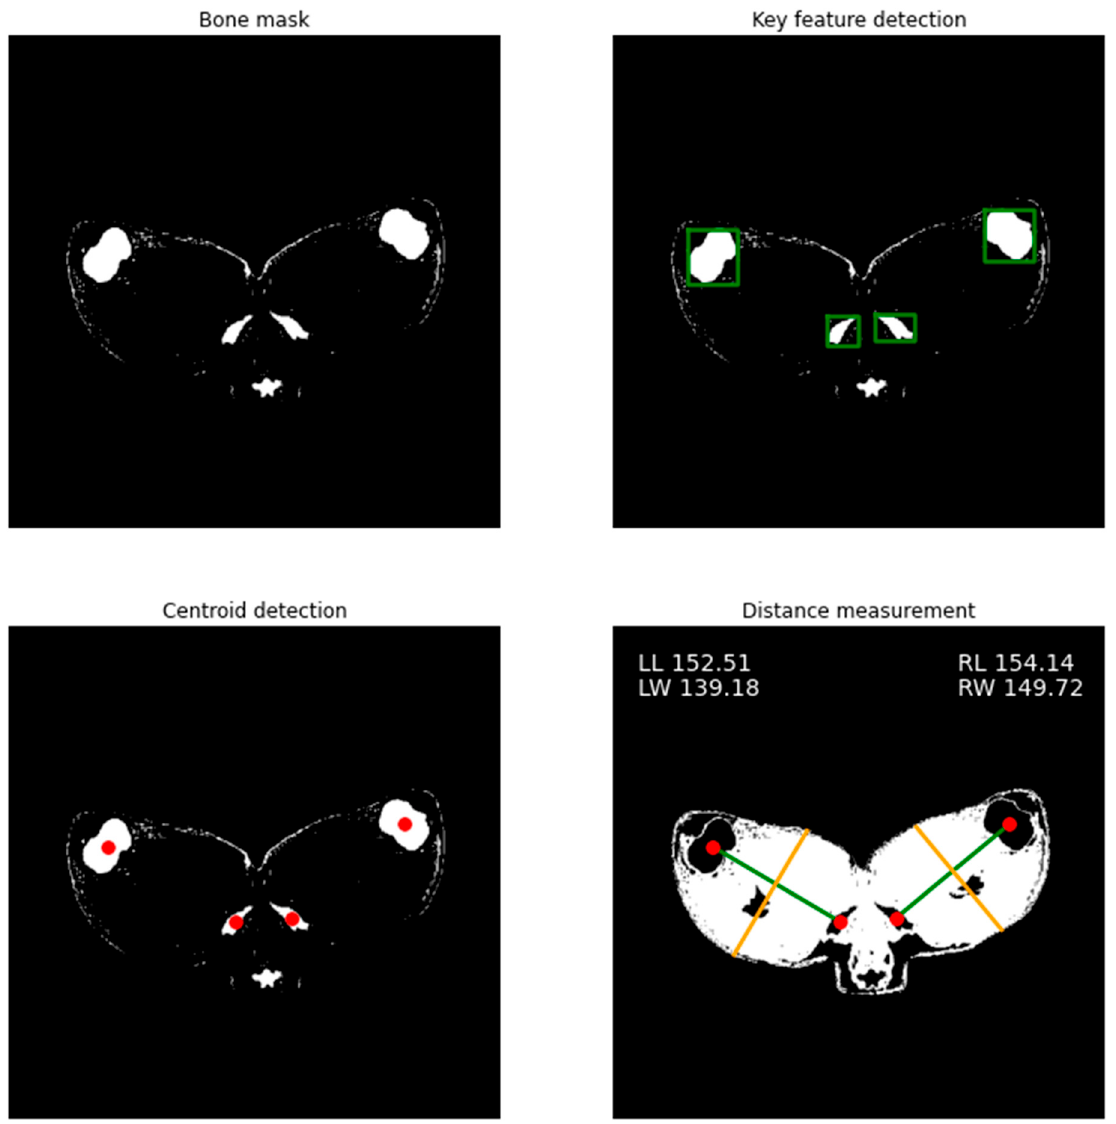
Figure 7. Automated identification of key features and determination of gigot length and width from predicted images. Using the bone tissue mask ( top left ) from the predicted image generated by the GAN, key features can be identified ( top right ). The centroid of each object within each feature area can be calculated ( bottom left ) to then measure distances and determine gigot length (LL, RL bottom right ). By taking the perpendicular equation of the line which connects the two pairs of bones, the width of the gigot (LW, RW, bottom right ) can be calculated by discovering the first and last non-zero values of these positions within the muscle tissue mask. Left and right gigot lengths on average were 164.45 ± 8.72 mm and 166.38 ± 9.71 mm with widths being 137.55 ± 10.53 mm and 143.99 ± 12.42, respectively.